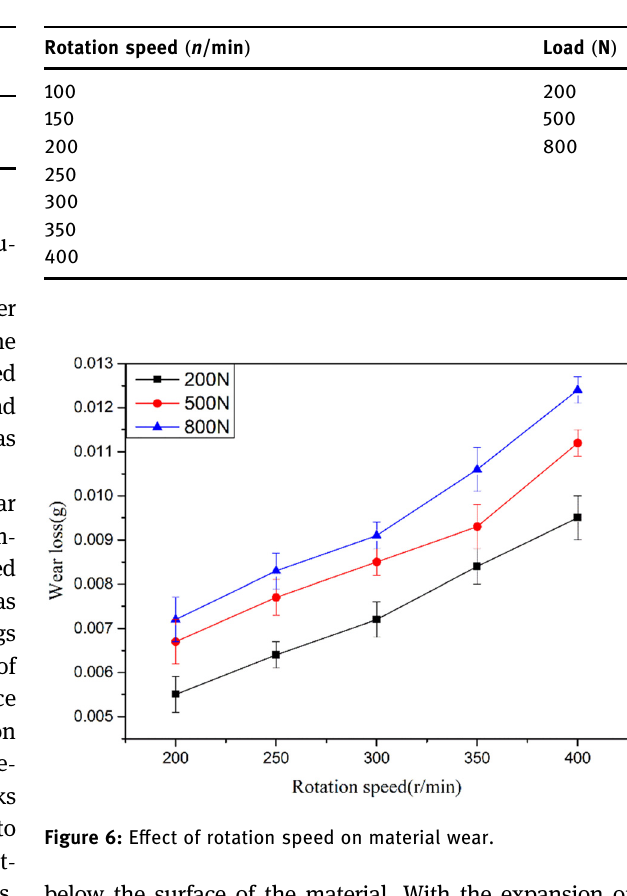
Table 6: Dry slip wear test scheme